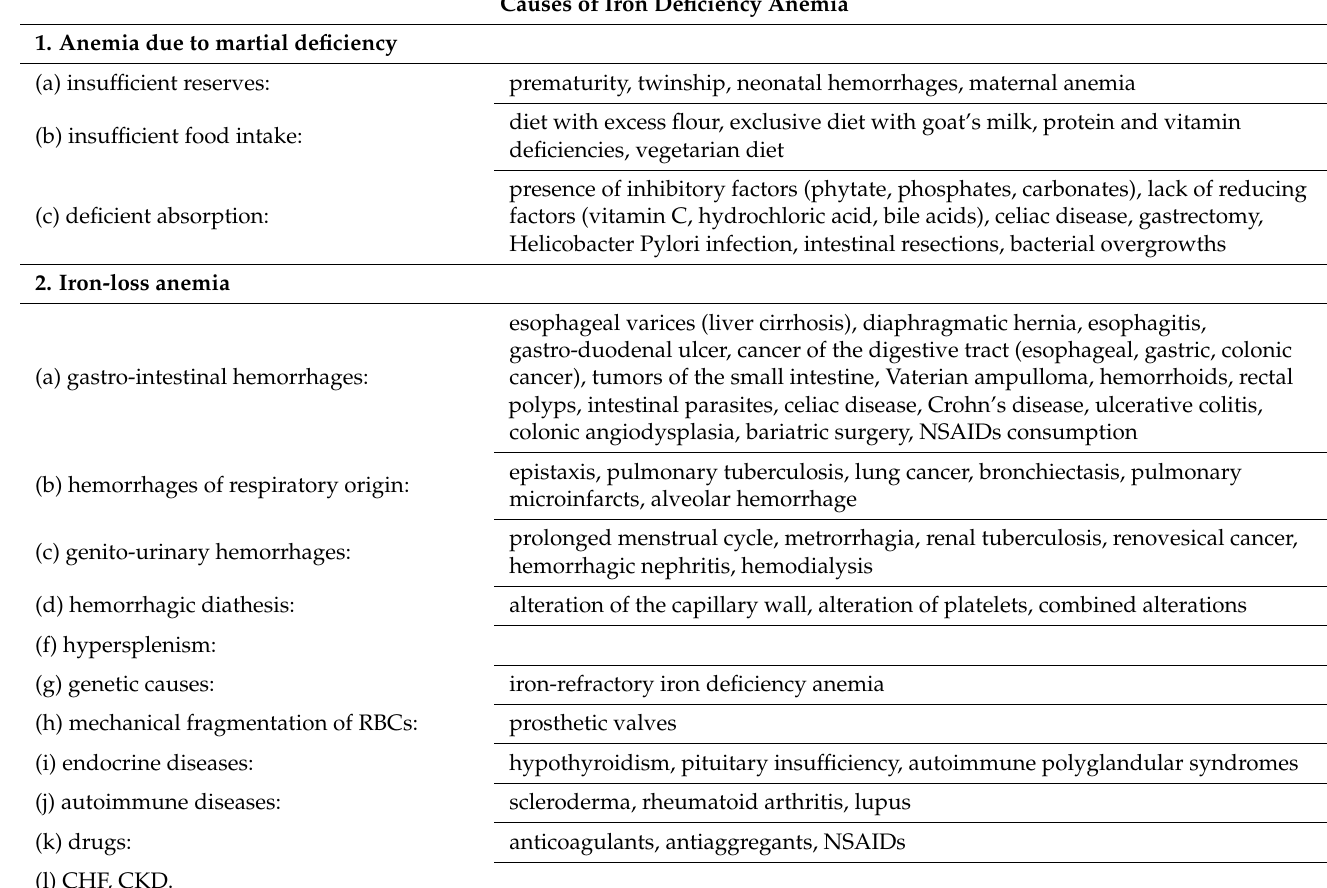
Table 1. Possible causes for iron deficiency anemia NSAID, a nonsteroidal anti-inflammatory drug. CHF, chronic heart failure. CKD, chronic kidney